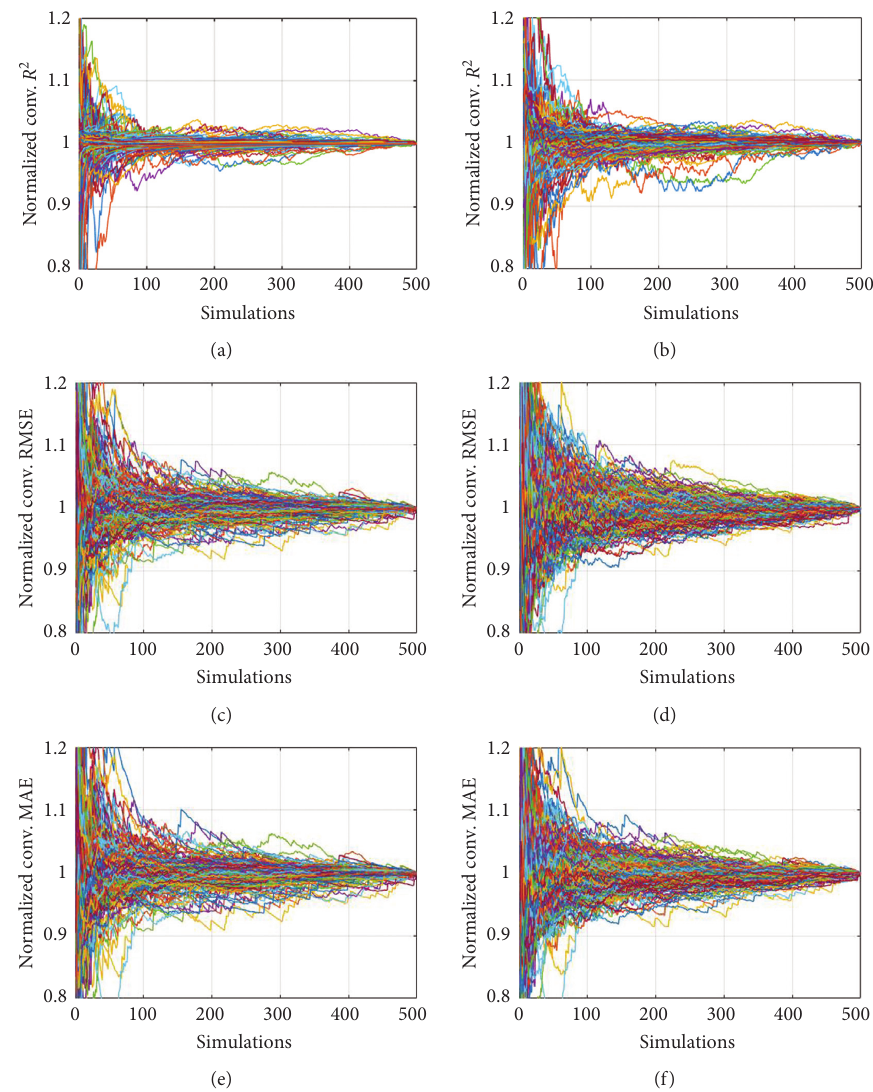
Figure 4: Convergence analysis for different ANN architecture with respect to (a) R 2 of the training parts; (b) R 2 of the testing part; (c) RMSE of the training part; (d) RMSE of the testing part; (e) MAE of the training part; and (f) MAE of the testing